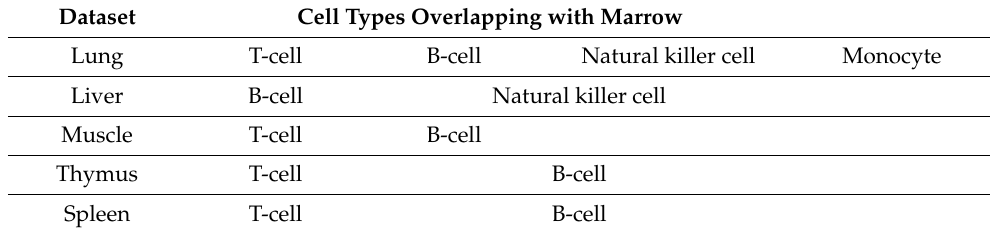
Table 3. Cell types from SMART-seq2 bone marrow samples, also present in other SMART-seq2 datasets.